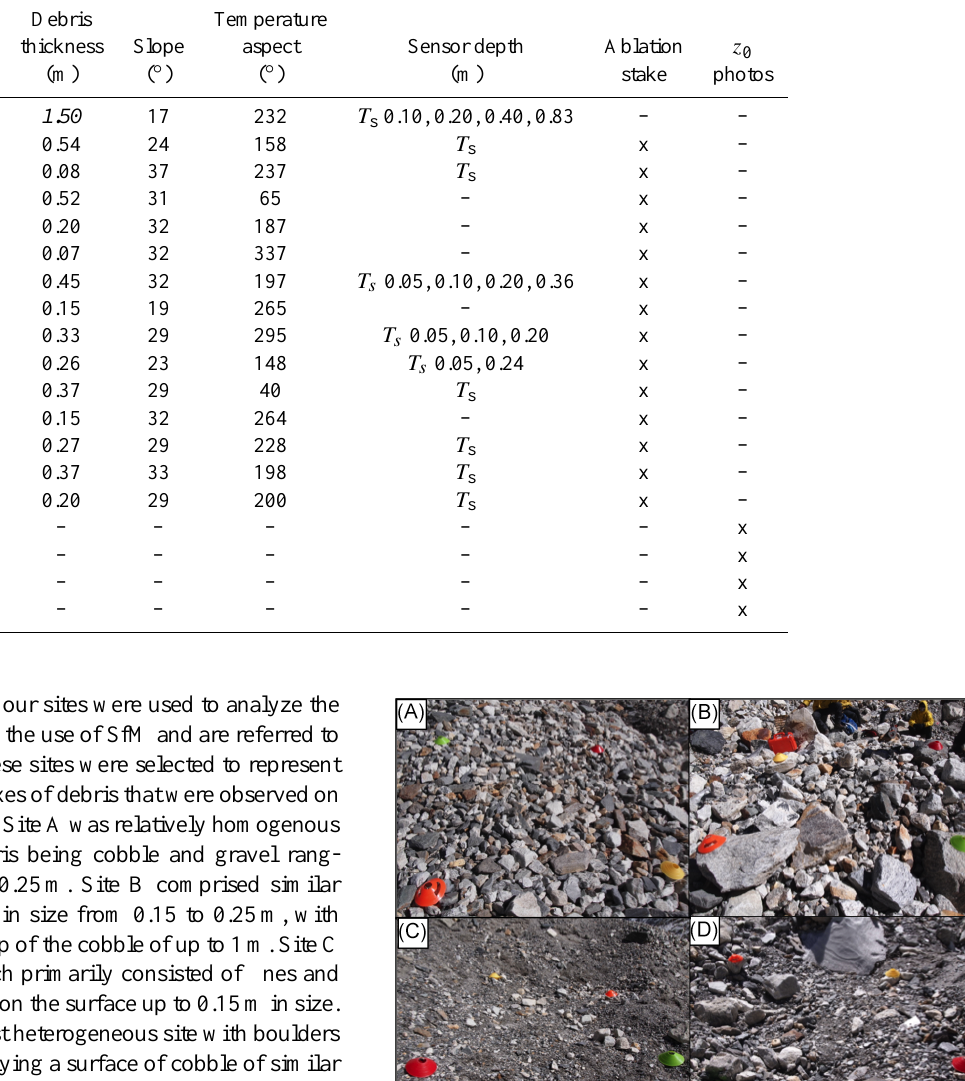
Table 1. Details of the debris thickness, topography, and monitoring equipment installed at each site. The use of italics notes an estimation of debris thickness. T s denotes surface temperature.